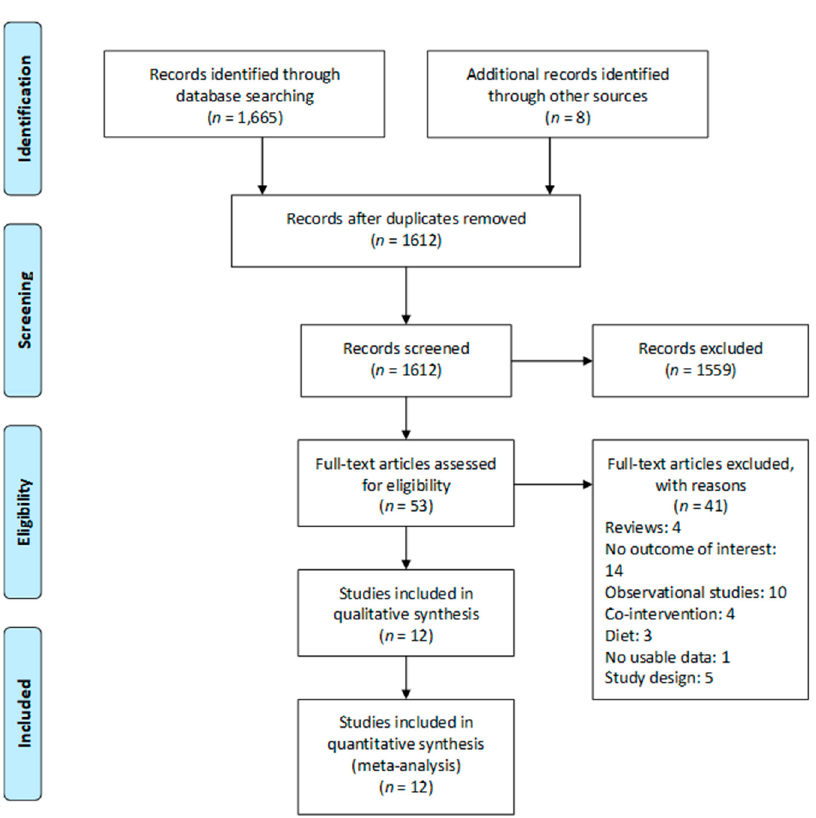
Figure 1. Preferred Reporting Items for Systematic Reviews and Meta-analyses (PRISMA) dia- gram.